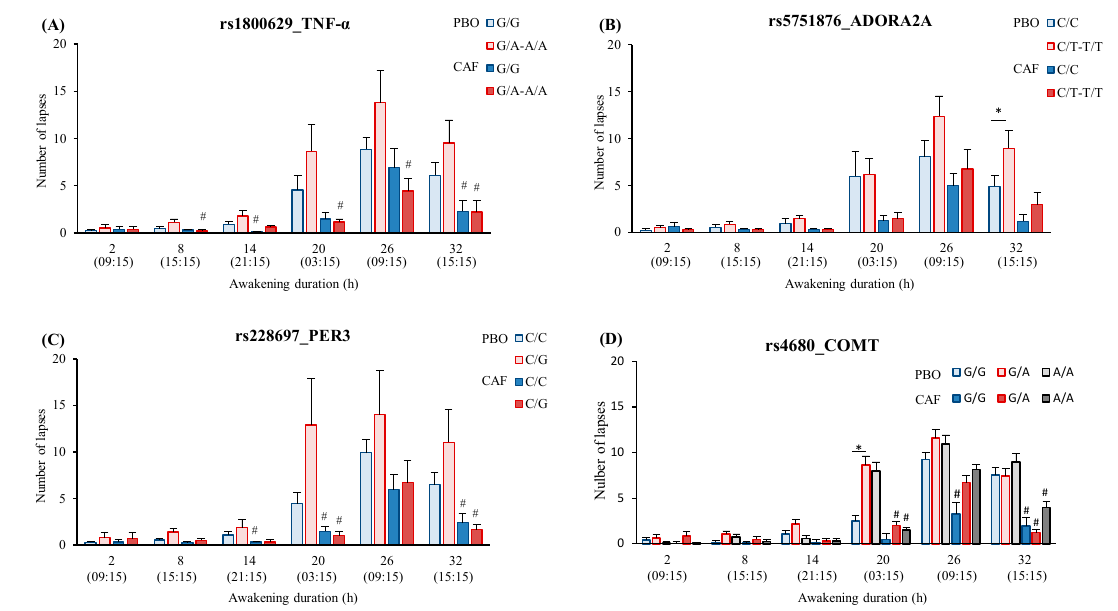
Figure 3. PVT number of lapses across consecutive 6-h intervals of awakening according to polymorphisms of TNF- α ( A ), ADORA2A ( B ), PER3 ( C ), and COMT ( D ) in placebo (PBO) and caffeine (CAF) conditions. Caffeine was consumed 45-min before PVT after 2-h, 8-h, 26-h, and 32-h of prolonged wakefulness. * is a SNP difference ( p < 0.05), # is a treatment difference ( p < 0.05) for one genotype.